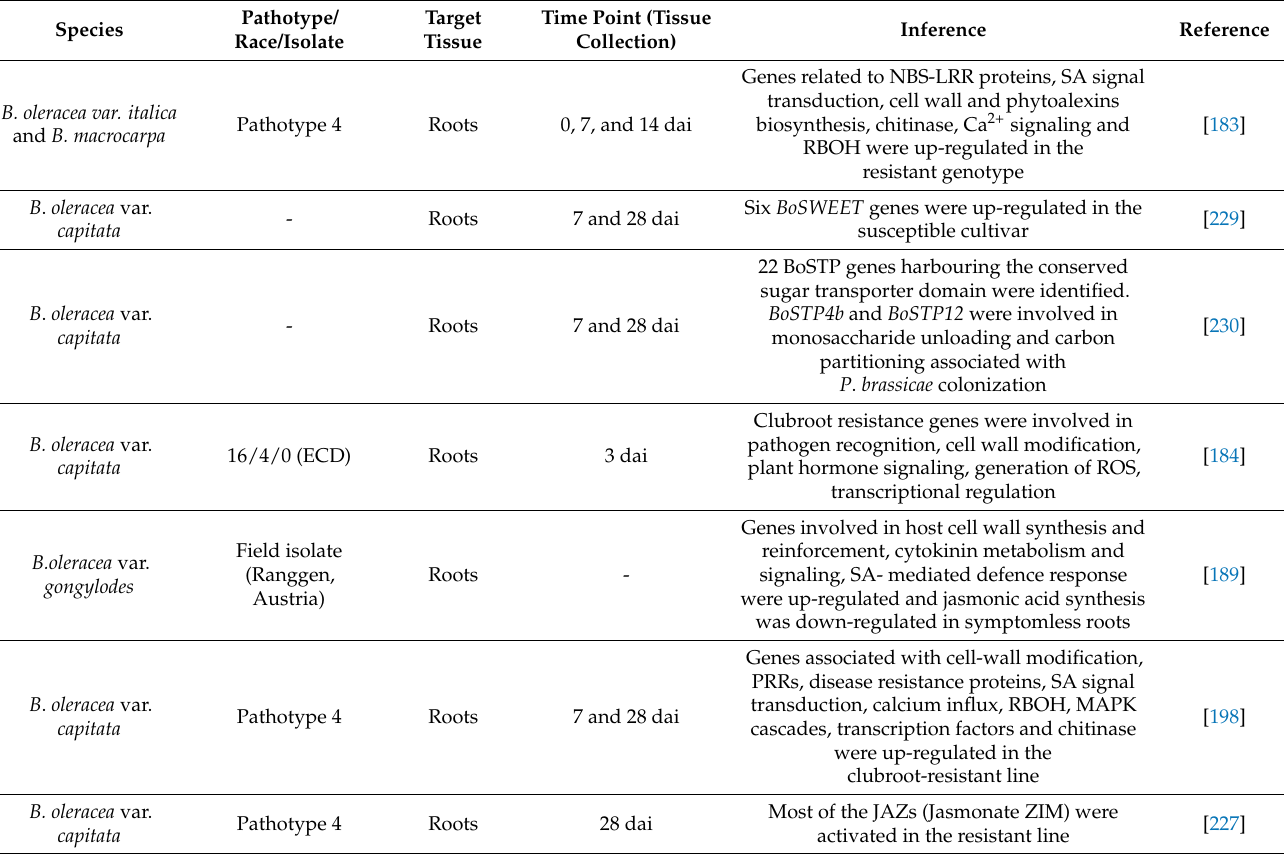
Table 3. Published transcriptomic and differential gene expression studies in Brassica spp. on clubroot